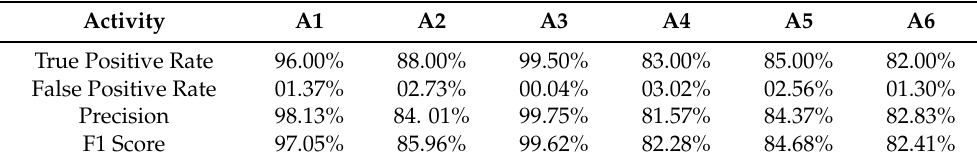
Table 7. The results of our proposed approach obtained for the first evaluation